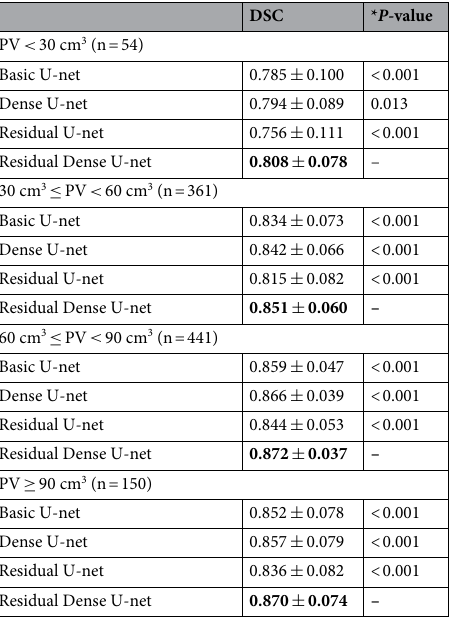
Table 3. Comparison of pancreas segmentation performance according to pancreatic volumes using four independent 3D networks. Results are indicated as mean ± standard deviation, and the best performances are indicated in bold. PV, pancreatic volume; DSC, dice similarity coefficient. *We used a paired t test to compare the residual dense u-net with the corresponding network and used a significance level of